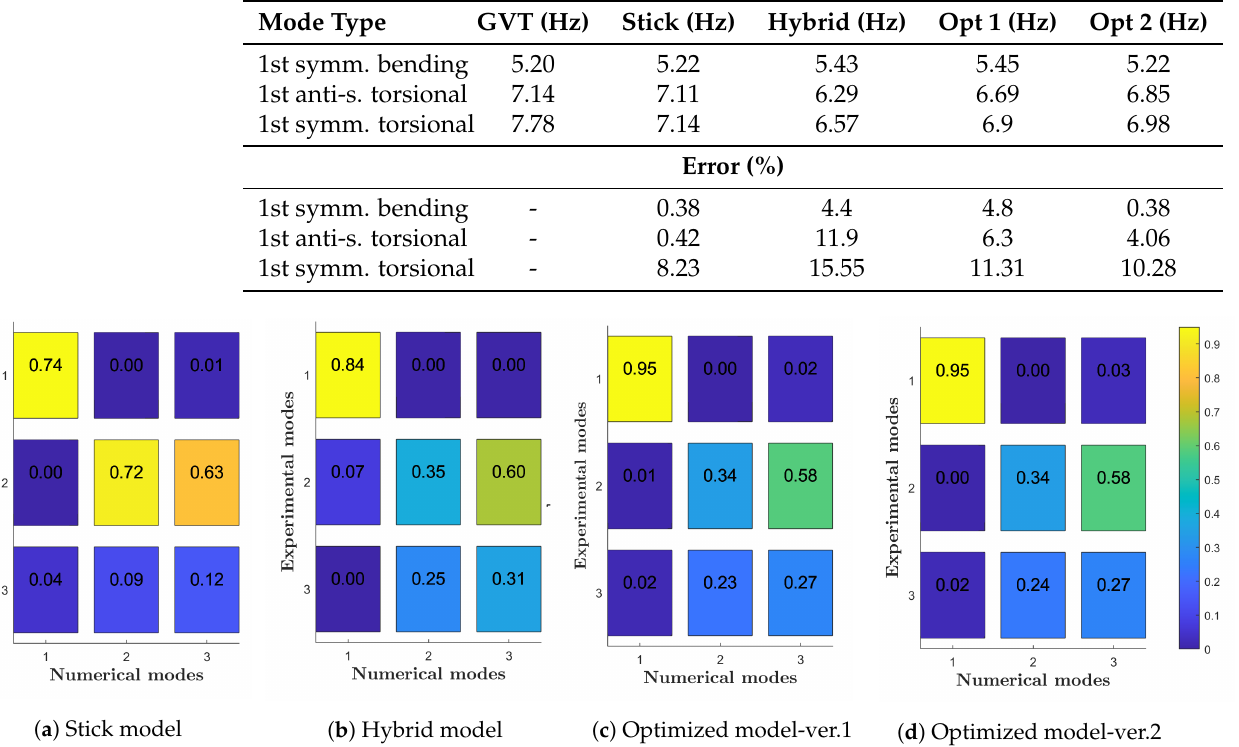
Figure 16. Cross-MAC matrices of the mass-forward